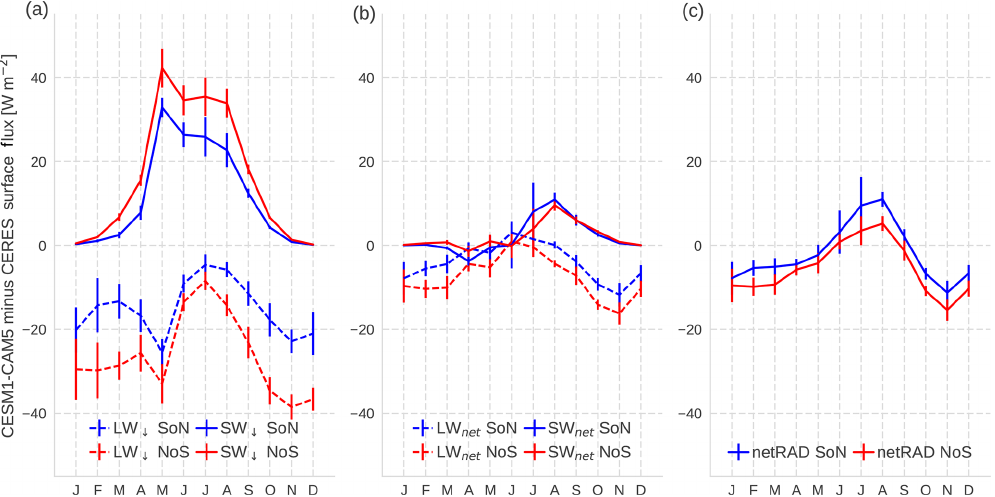
Figure 5. CESM1-minus-CERES 60–90 ◦ N ocean differences in mean surface fluxes for each calendar month over 2001–2005. Differences are shown for both CESM1-SoN (blue) and CESM1-NoS (red). Error bars are estimates of internal variability only, based on standard deviations of non-overlapping 5-year periods in each series after detrending the annual data. (a) Differences in downward longwave (dashed) and downward shortwave (solid) radiation. (b) Difference in net longwave (dashed, positive downward) and net shortwave (solid) radiation. (c) Net downward radiation sum. All values are defined such that positive indicates a case in which the model value shows greater net downward flux than the CERES